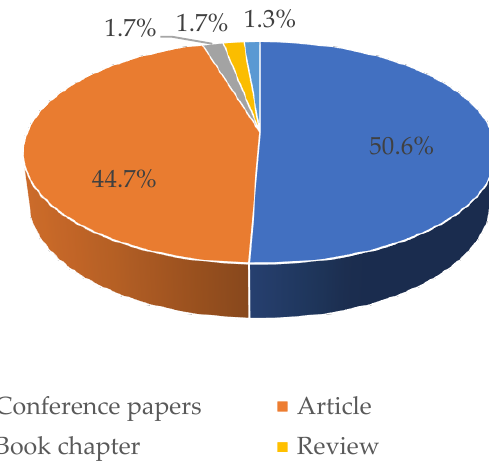
Figure 3. The academic publications included in this study.